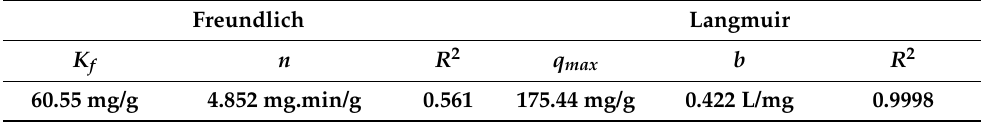
Table 4. Characteristics of ZrO 2 /CS adsorption isotherm with U(VI). Freundlich Langmuir